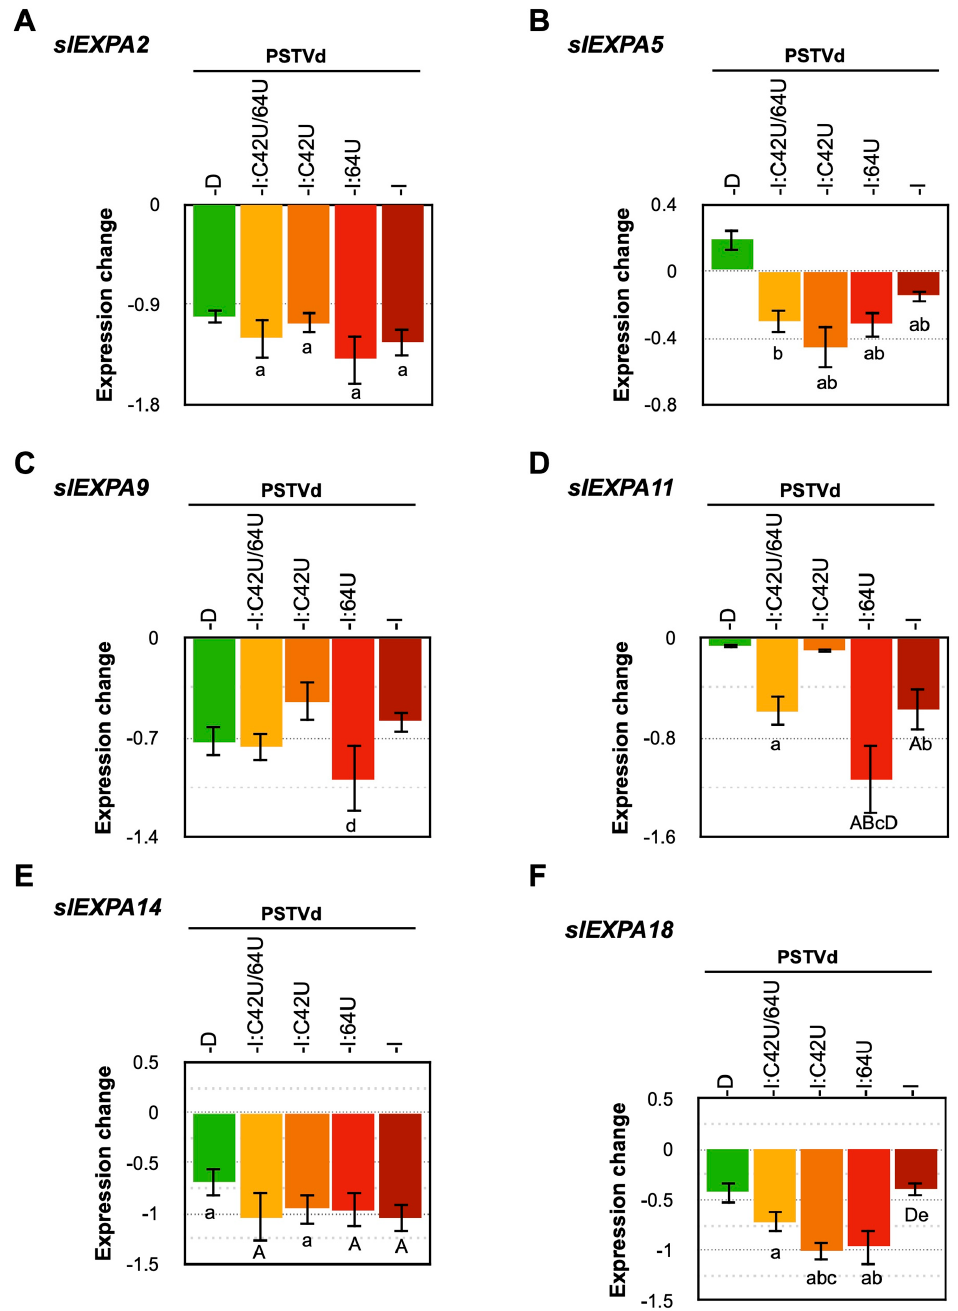
Figure 5. PSTVd infection di ff erentially a ff ects the expression of six expansin genes of tomato. Total RNA extracted from tomato plants inoculated with LMW-RNA of PSTVd-D wt , PSTVd-I wt and mutants of PSTVd-I (PSTVd-I:C42U / 64U, PSTVd-I:C42U, and PSTVd-I:64U) at 3-wpi were assayed by RT-qPCR to analyze the expression level of ( A ) EXPA 2, ( B ) EXPA 5, ( C ) EXPA 9, ( D ) EXPA 11, ( E ) EXPA 14, and ( F ) EXPA 18 mRNAs. The vertical axis indicates the relative expression level (Log2) of mRNAs. The data were normalized by the mean value of the mock-inoculated control at 1-wpi as 1.0. A t -test was performed with a p -value of 0.05. The plants that showed a di ff erence < 0.05 and < 0.01 are indicated by lower and capital letters on the top of the bars, respectively. In the figure, significant di ff erence against the mock-inoculated control plant, PSTVd-D wt , PSTVd-I:C42U / 64U, PSTVd-I:C42U, and PSTVd-I:64U is represented as a or A, b or B, c or C, d or D, and e or E, respectively. Mean values are based on three biological and three technical